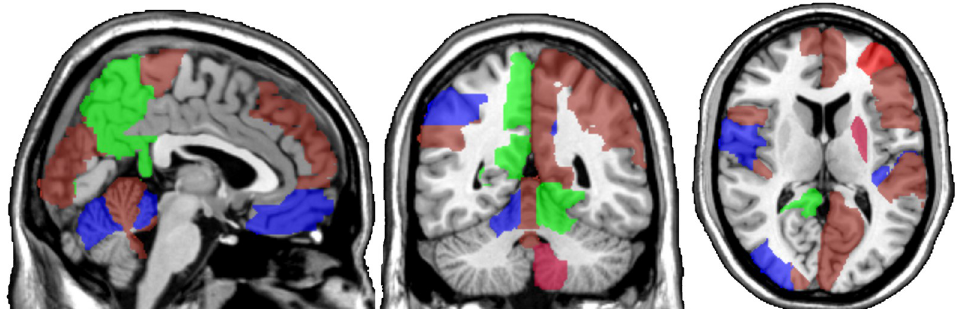
Fig 1. The regions of interests, the BOLD activities of which correlate the most with the ADHD score variability in a sample of subjects and achieve the lowest prediction error. The regions associated with ADHD are colored red, those associated with ADHD Hyper/Impulsive are blue, and the ones associated with ADHD Inattentive are colored